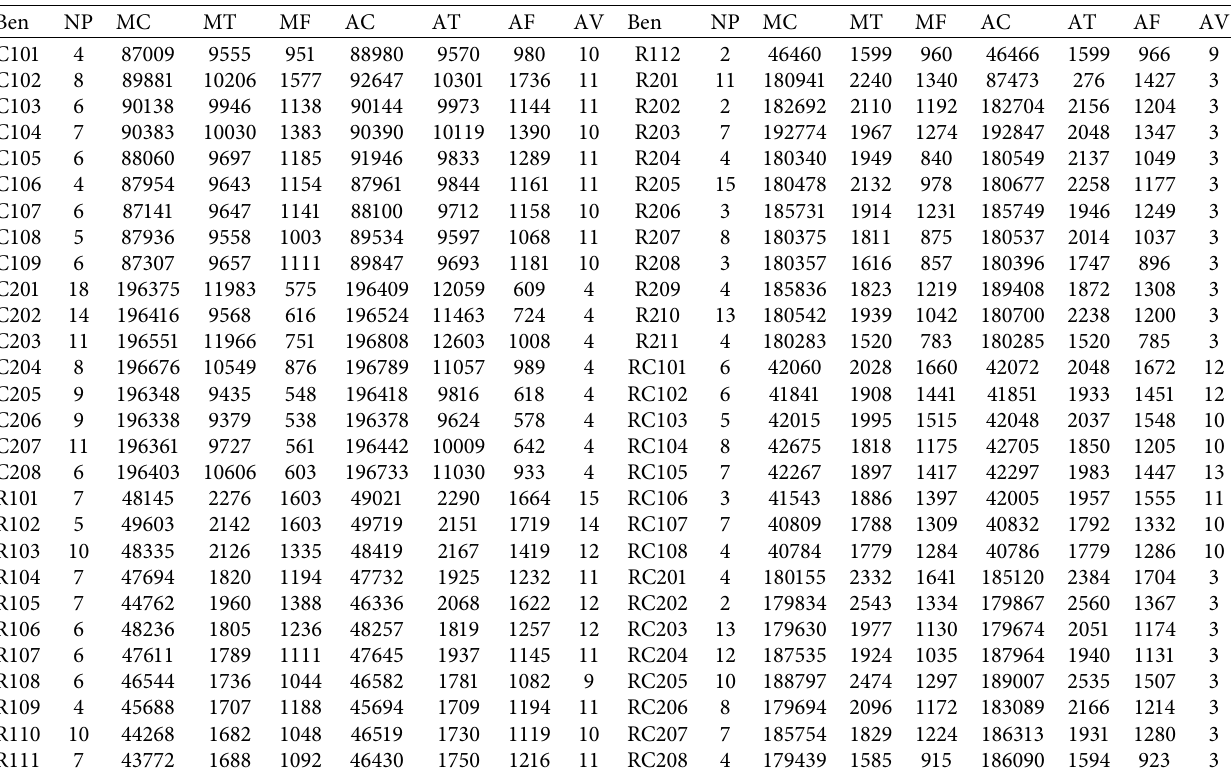
Figure 6: The curves of the combined values of RC201 and RC208. Table 11: The results of C1 ∼